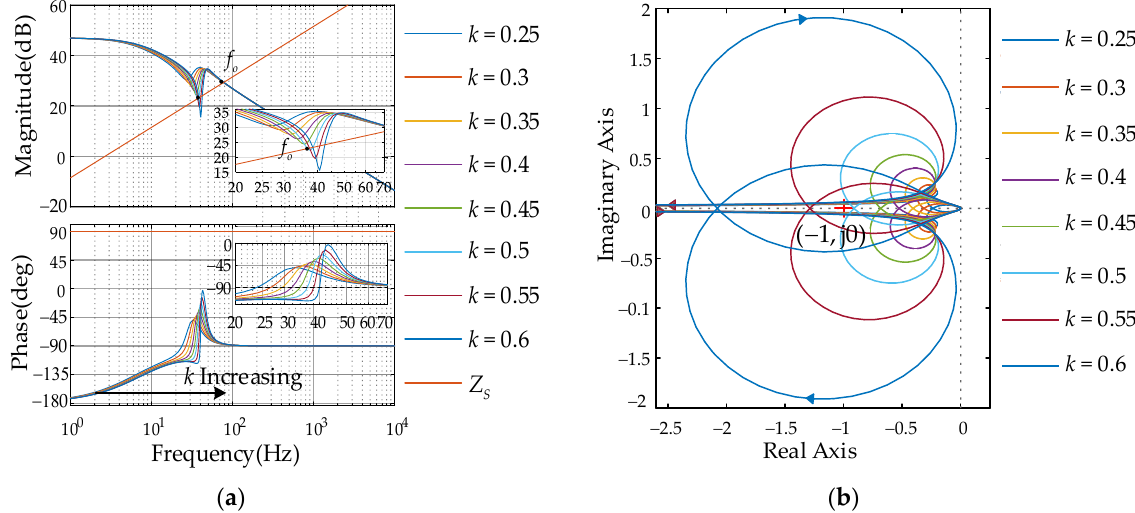
Figure 11. Stability analysis of the MVDC distribution system: ( a ) Bode diagram of Z L _ IPR ( j ω 0 ) , ( b ) Nyquist diagram of T m .